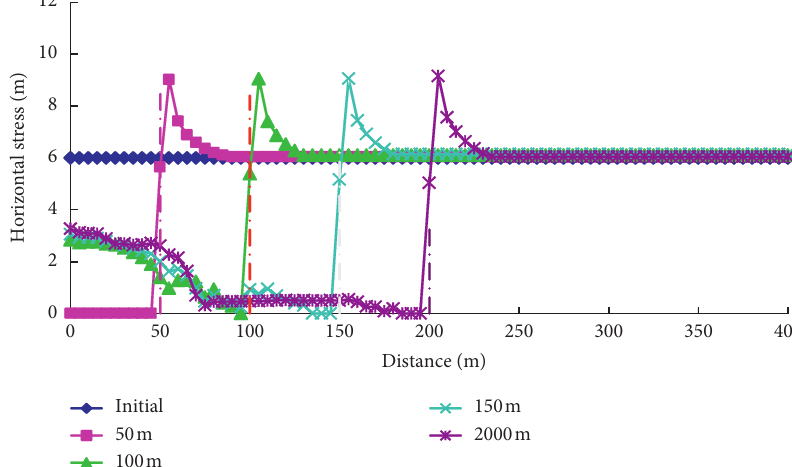
Figure 22: Distribution of strike horizontal stress in +550 horizontal working face after